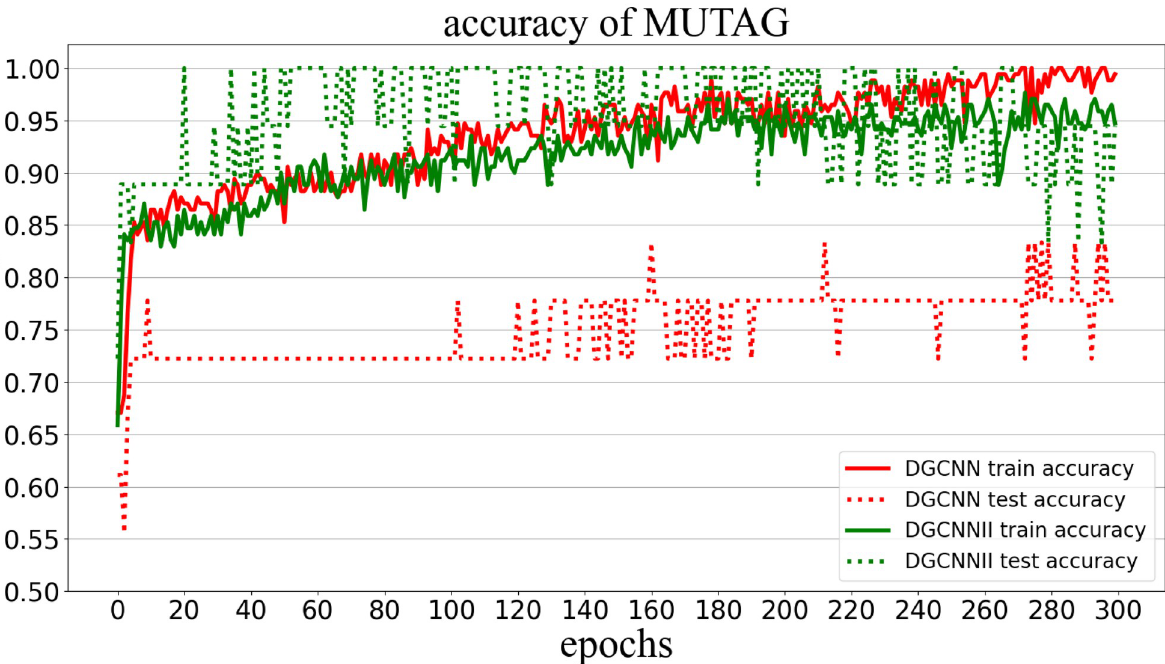
PLOS ONE | https://doi.org/10.1371/journal.pone.0279604 March 10,